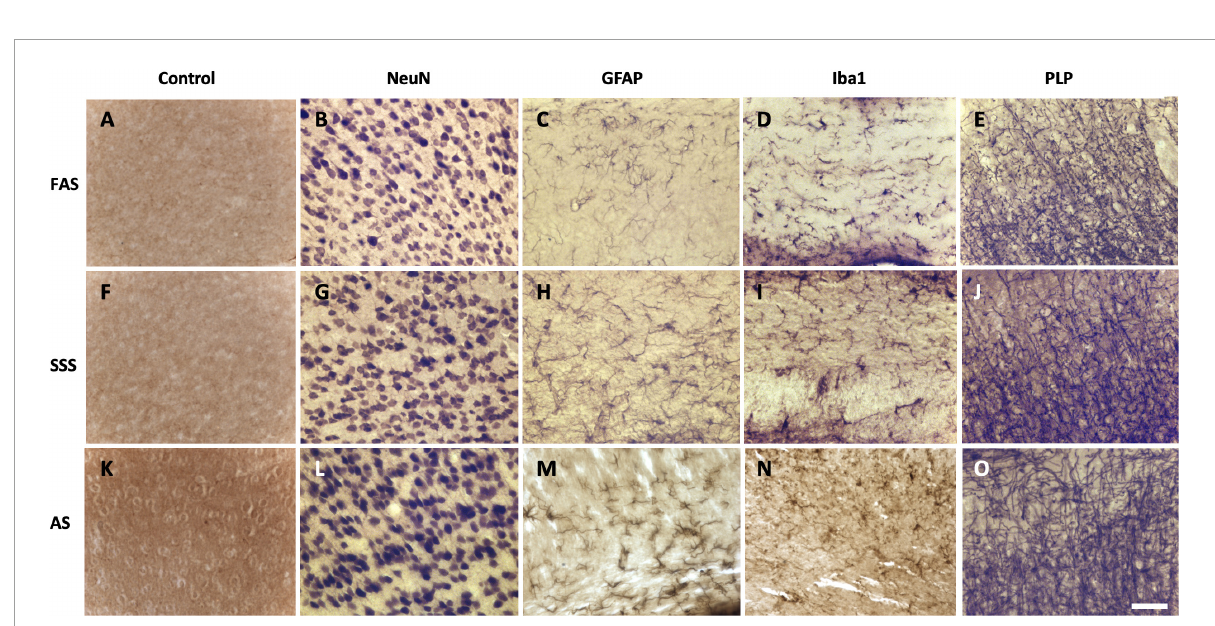
FIGURE5 Photomicrographs (40X) of the different antigens of brain samples fixed with three different solutions. (A,F,K) Negative control sections, (B,G,L) neuronal cell bodies (NeuN), (C,H,M) astrocytes (GFAP), (D,I,N) microglia (Iba1), and (E,J,O) myelin fibers (PLP) fixed with FAS, SSS, and AS, respectively. Photomicrographs were acquired in layers 2–3 of the secondary motor cortex of sections from 0.04 to 0.46 mm posterior to Bregma (the Mouse Brain Atlas). Photomicrographs were acquired in similar background specimens (light for NeuN and Iba1, intermediate for GFAP and PLP) to increase the visual comparability of the antigens, by avoiding any dark backgrounds. Scale bar = 100 µ